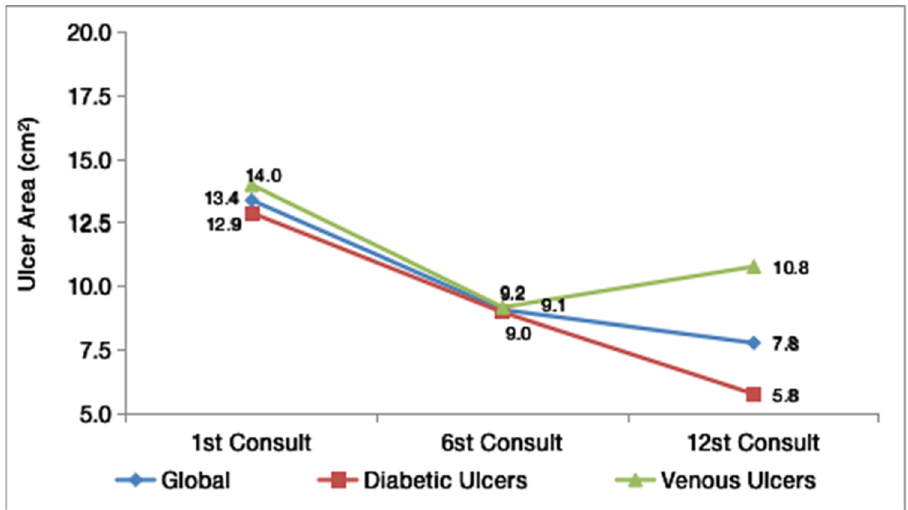
Figure 1. The evolution of the mean area of the lesion in the three evaluations.